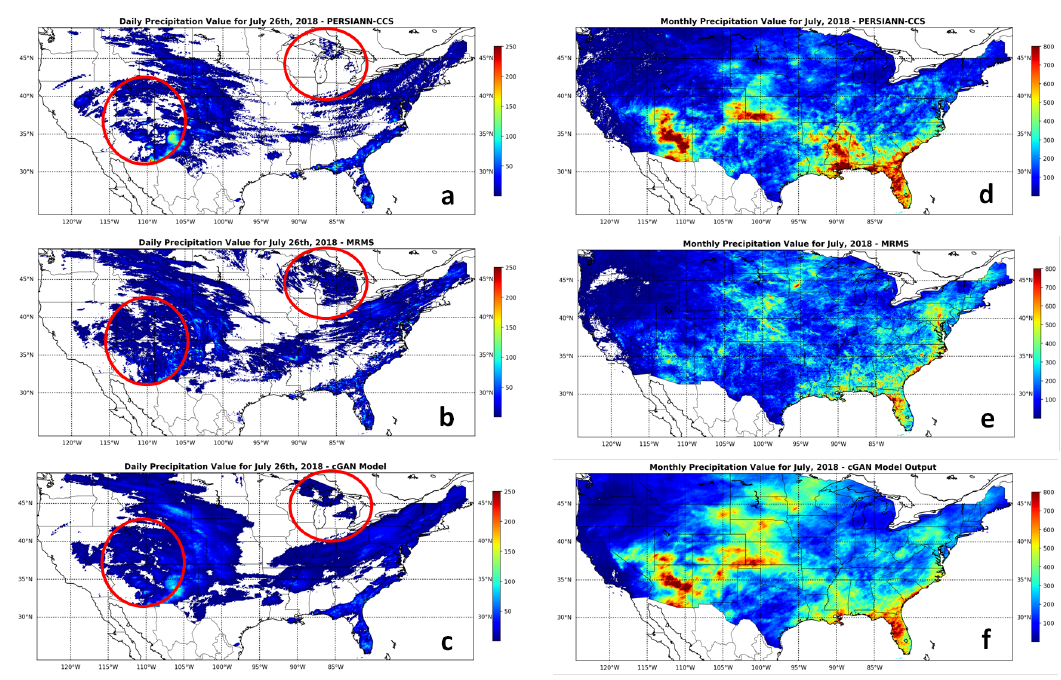
Figure 5. Daily ( left panel ) and monthly ( right panel ) precipitation values for ( a , d ) PERSIANN-CCS; ( c , f ) cGAN model output compared to the ( b , e ) Reference data—MRMS. Red circles are highlighting regions with most of the differences.